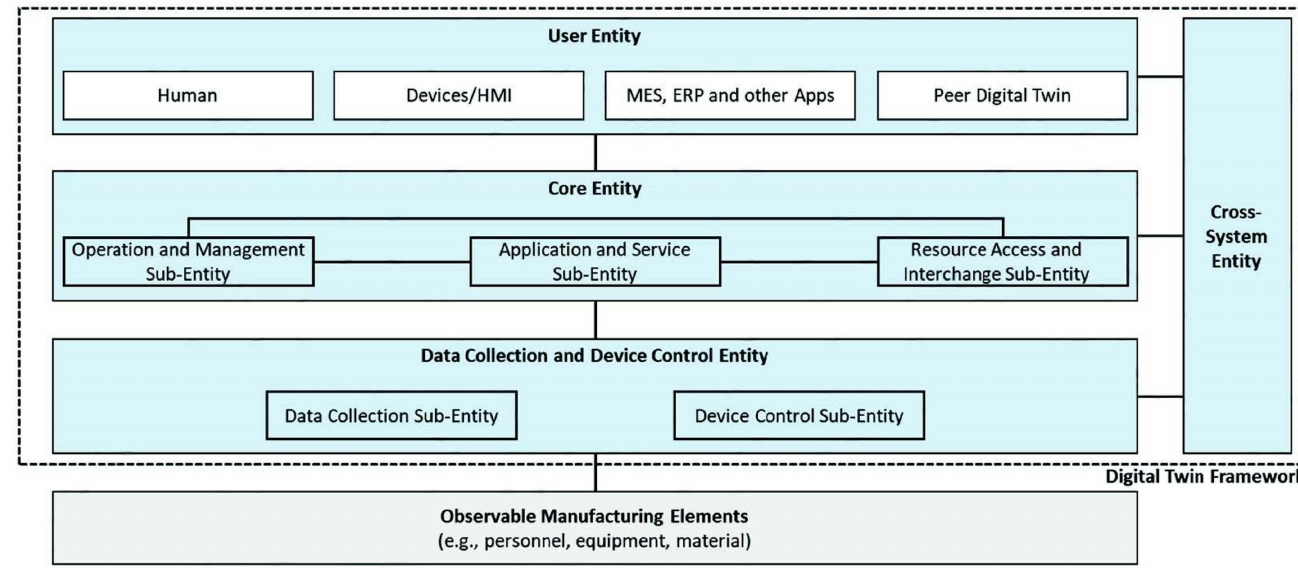
Figure 1. Entity-based digital twin reference model for manufacturing according to ISO 23247-2